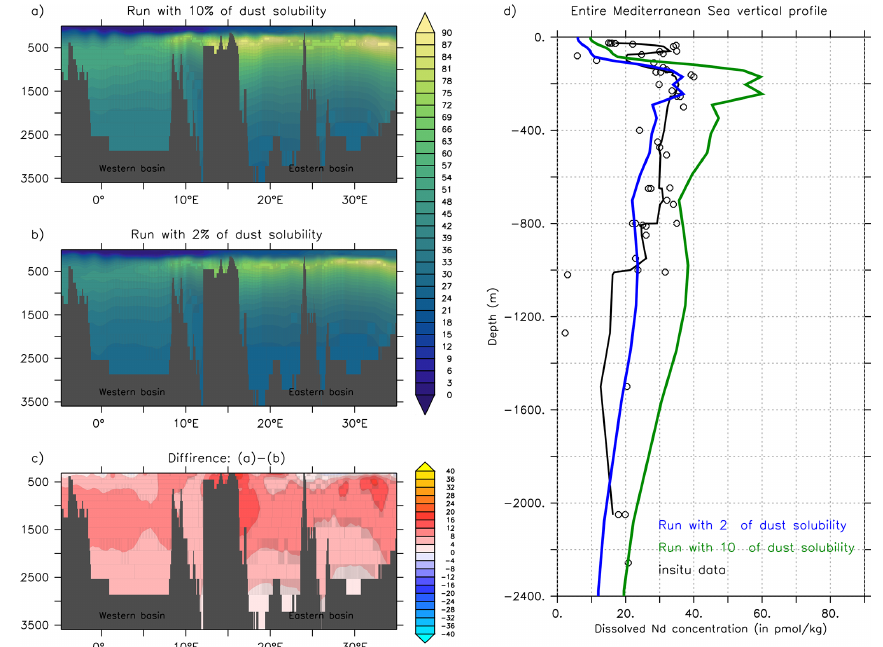
Figure A3. Left panel is the E–W vertical section of [Nd] (in pmolkg − 1 ) in the entire Mediterranean Sea based on a 10% of dust solu- bility (a) , a 2% of dust solubility (b) , and the difference between the two (c) . Right panel is the comparison of average vertical profiles of [Nd] (in pmolkg − 1 ) in the whole Mediterranean Sea from the two experiments (the experiment of 2% of dust solubility in blue and the experiment based on a 10% of dust solubility in green) against in situ data (black line) from Tachikawa et al. (2004); Vance et al. (2004); Henry et al. (1994); Dubois-Dauphin et al. (2017); Garcia-Solsona and Jeandel (2020); Montagna et al. (2022).